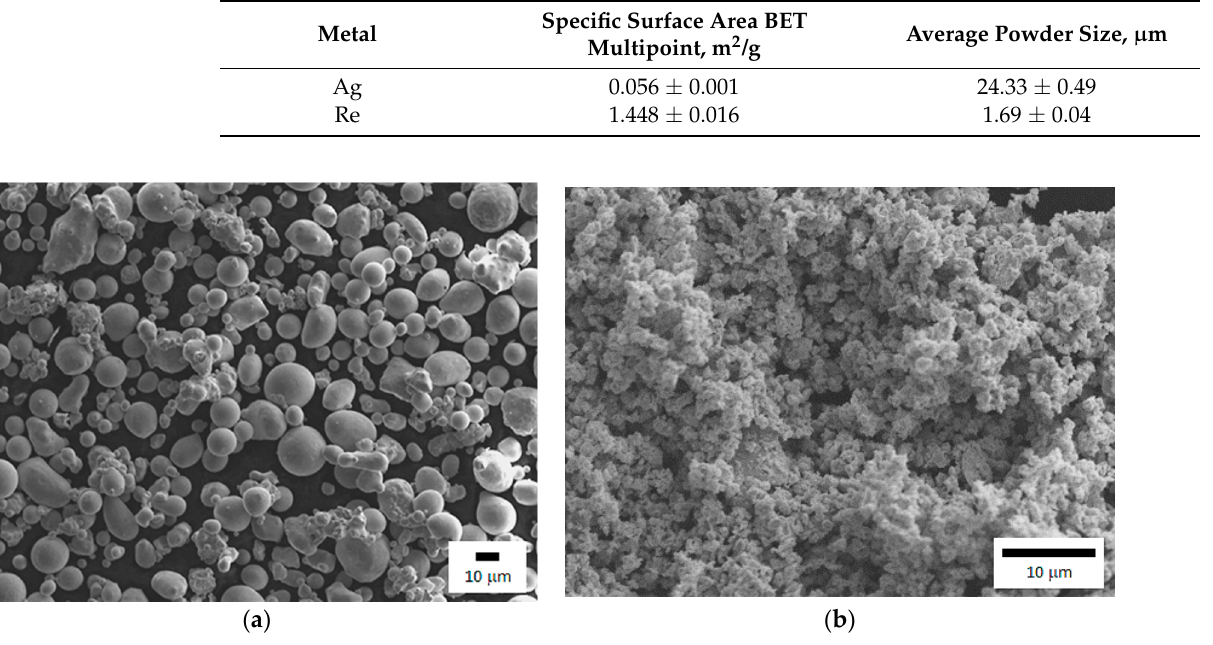
Figure 1. Powder morphology: ( a ) silver; ( b ) rhenium. Table 1. Properties of powders used for manufacturing contact materials.